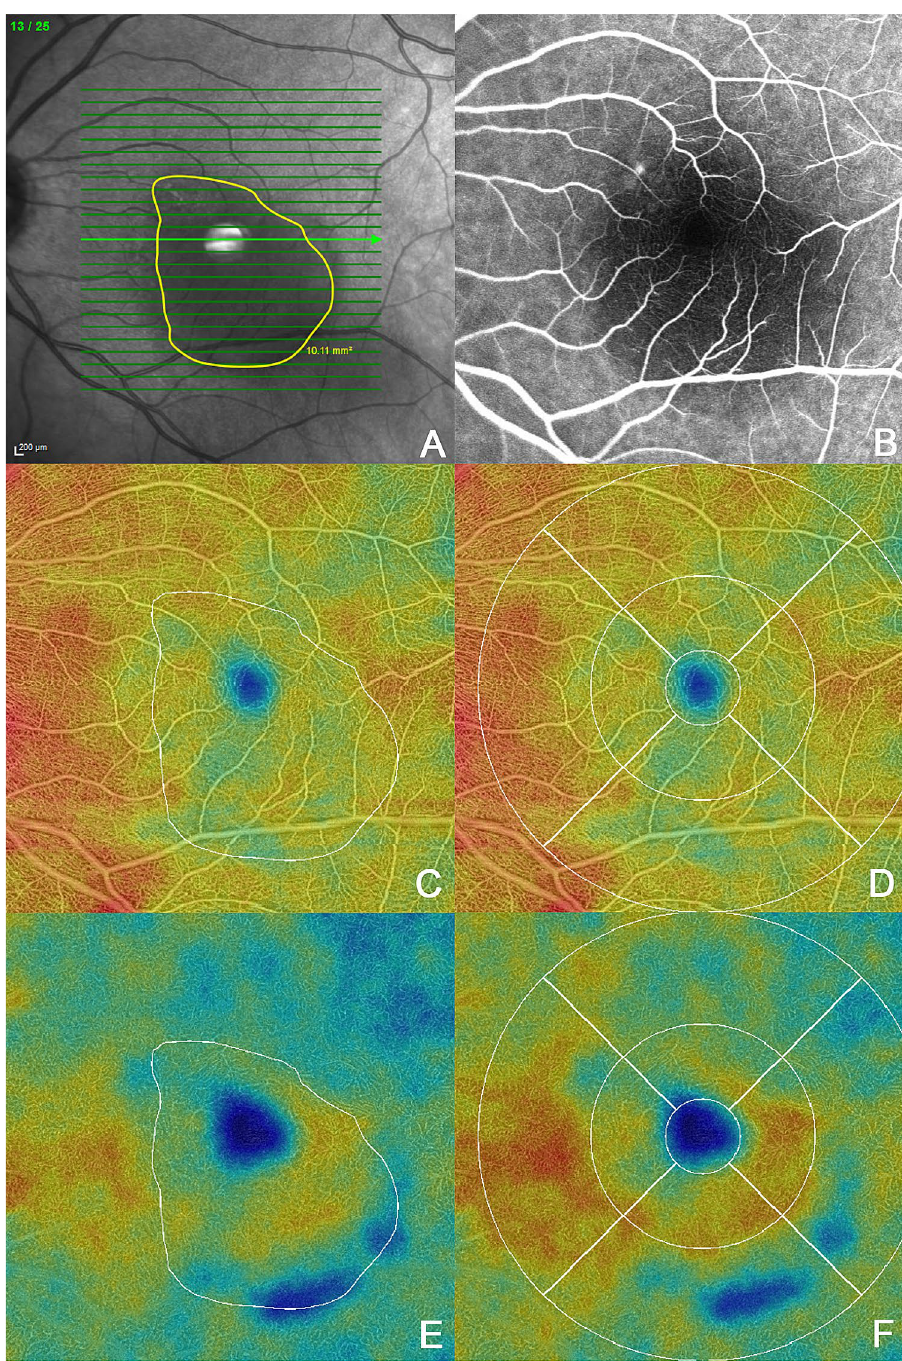
Figure 2. Example of vessel and perfusion density analysis. ( A ) En face image with annotated subretinal fluid (SRF) ( B ) Fluorescein angiogram at baseline showing a staining spot. ( C ) Marked SRF area on color-coded perfusion density map of the superficial capillary plexus (SCP) ( D ) 6 mm circle on color-coded perfusion density map of the SCP ( E ) Marked SRF area on color-coded perfusion density map of the deep capillary plexus (DCP) ( F ) 6 mm circle on color-coded perfusion density map of the